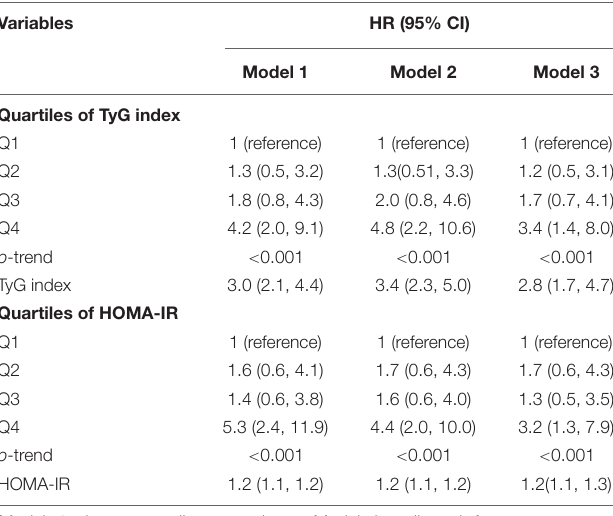
Model 1 does not adjust covariates. Model 2: adjusted for age, sex and race. Model 3: model 2 + adjusted for education, obesity, smoking status, hypertension, diabetes mellitus, hypercholesteremia, CKD, LDL-C and HDL-C. Abbreviations: HDL-C, high-density lipoprotein cholesterol; LDL-C, low-density lipoprotein cholesterol; TyG, Triglyceride-glucose; CKD, chronic kidney diseases; HOMA-IR, homeostasis model assessment-insulin resistance; CHF, chronic heart